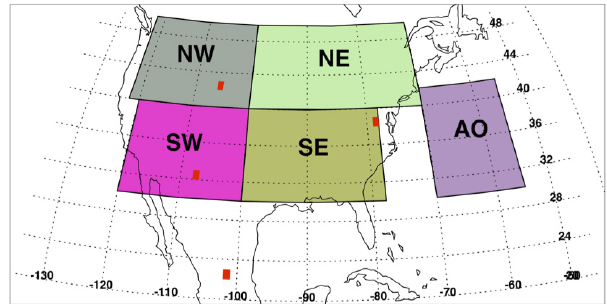
Fig. 5. The full study domain extends from the equator to 55 ◦ N and from − 139 ◦ to − 13 ◦ W longitude. The full domain is divided into 5 subdomains: NW, NE, SW, SE and AO. The small red squares de- note specific locations at 1 ◦ × 1 ◦ of more intense analysis: Wyoming (WY) in NW, New Mexico (NM) in SW, Virginia (VA) in SE, and Mexico (ME) south of